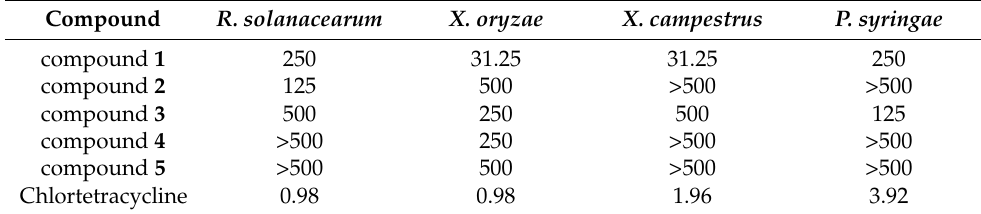
Table 4. Minimum inhibitory concentration of compounds (μ g/mL).